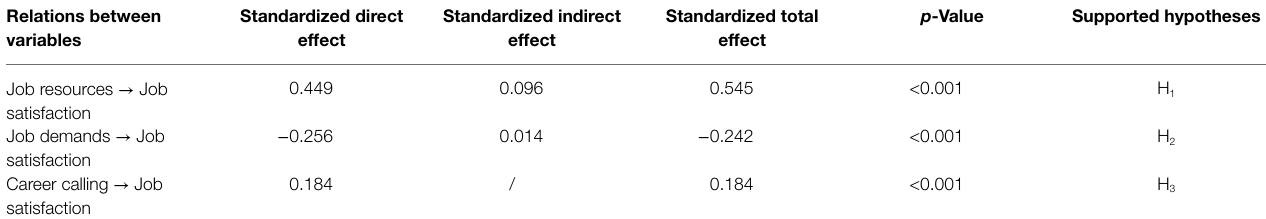
TABLE 7 | Path coefficients for job satisfaction and hypothesis verification.